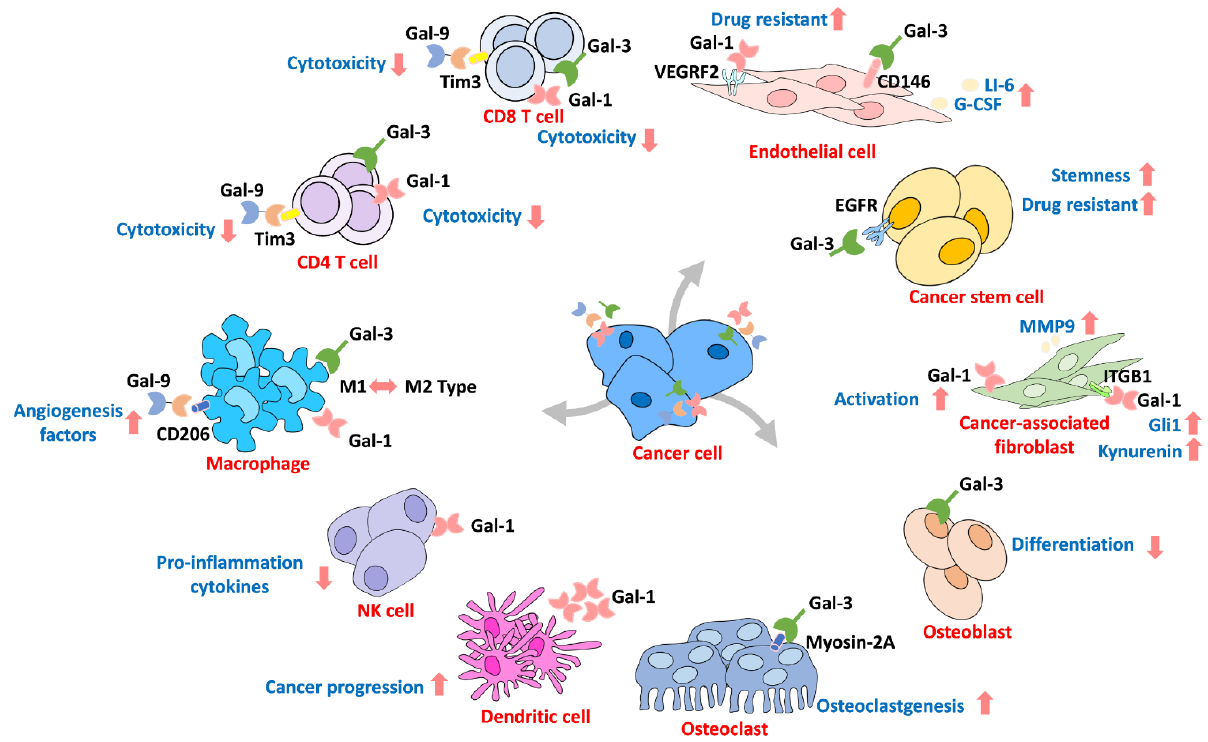
Figure 6. The galectin family contributes to tumor microenvironment reprogramming. Gals can act as a reprogramming messenger to connect tumor cells and other cells in the microenvironment. ↑ , ↓ Means increase or decrease.